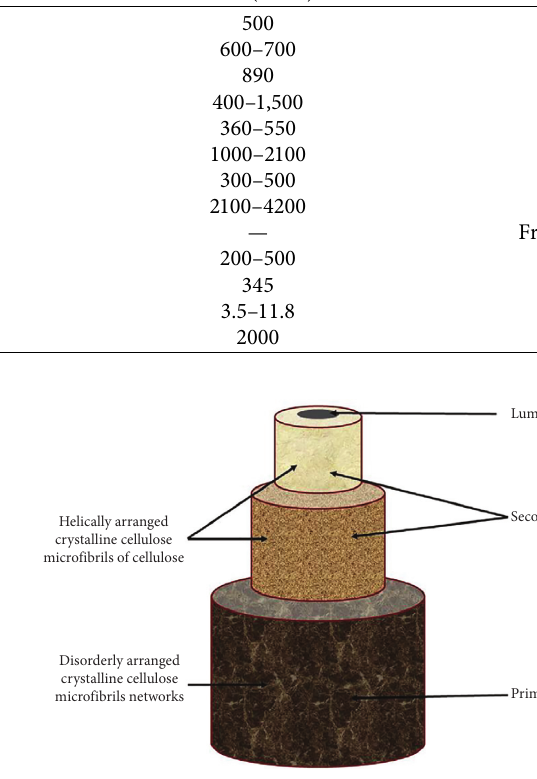
Figure 1: Structure of natural fibre